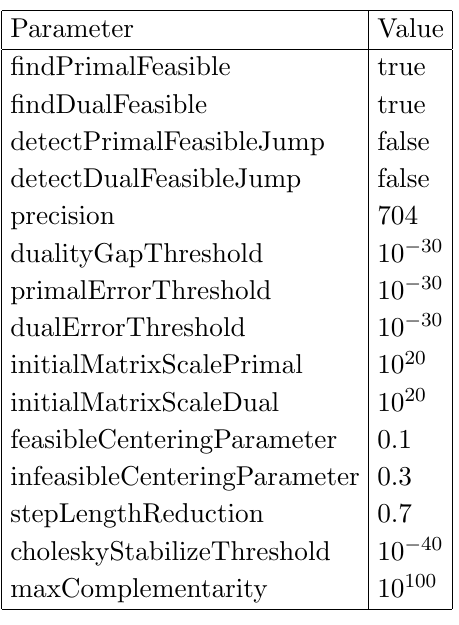
Table 7 . Parameters employed in the SDBP